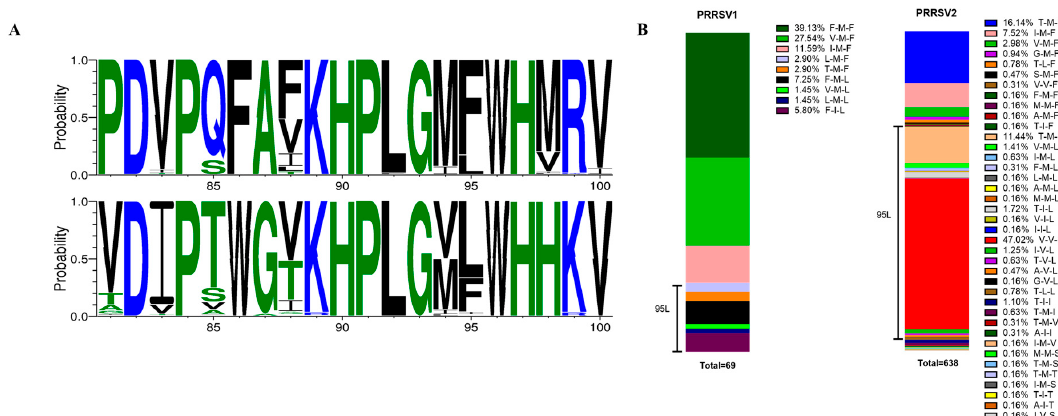
Figure 6. A graphical representation of an amino acid multiple sequence alignment of the GP2a protein (fragment covering amino acid residues at positions 81–100) from type 1 ( n = 69) and type 2 ( n = 638) PRRSVs ( A ). Logo image consists of stacks of symbols, one stack for each position in the sequence. The height of symbols within the stack indicates the relative frequency of each amino acid for PRRSV1 and